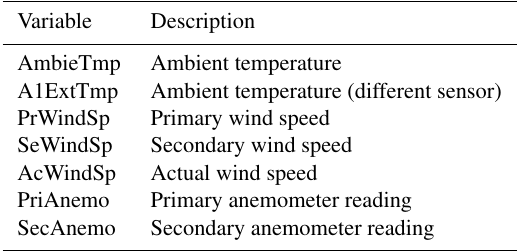
Table 4. External selected measurements.